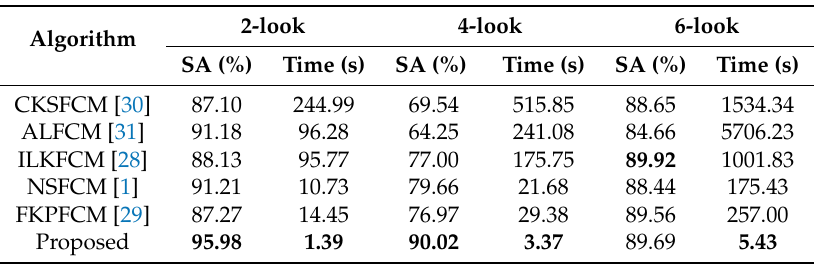
Table 4. Segmentation results on real SAR